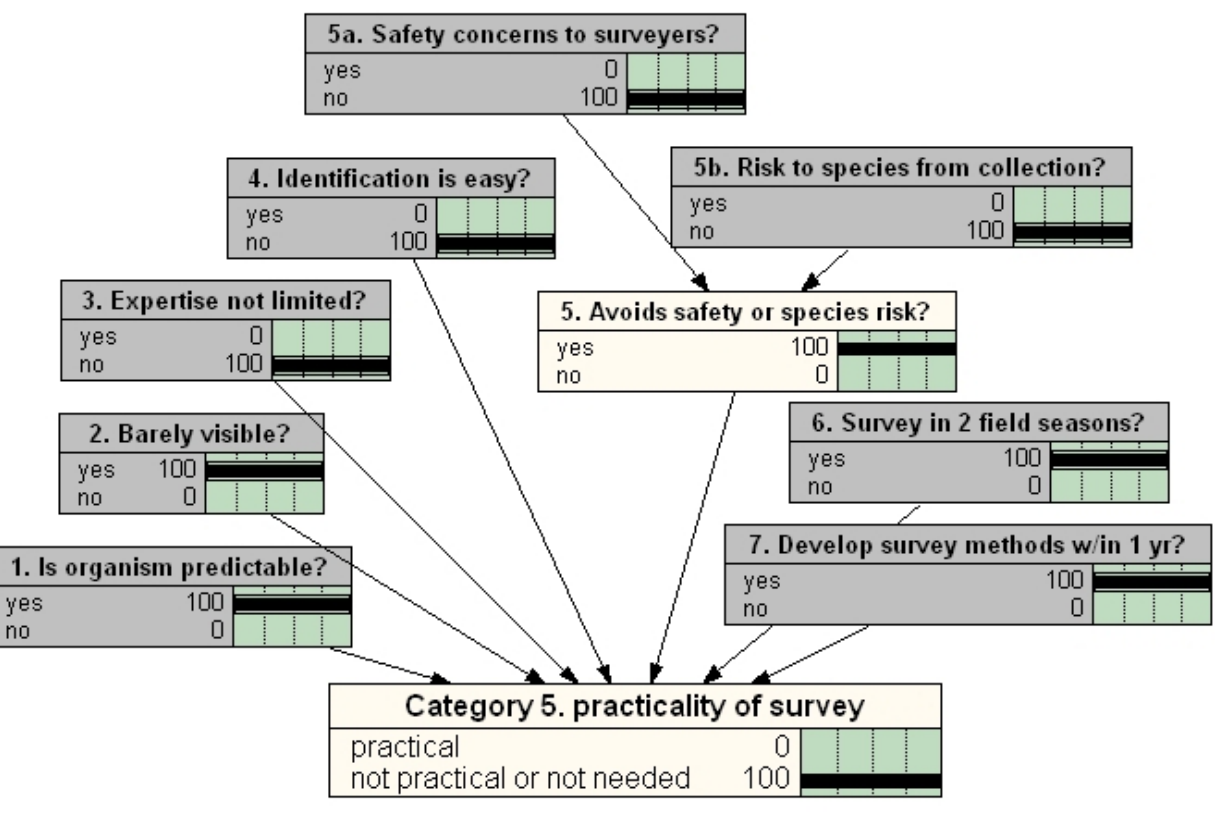
Fig. 6. Bayesian belief network (BBN) submodel for determining evaluation category 5, practicality of survey. See Table 2 for Record of Decision guidelines used to develop this